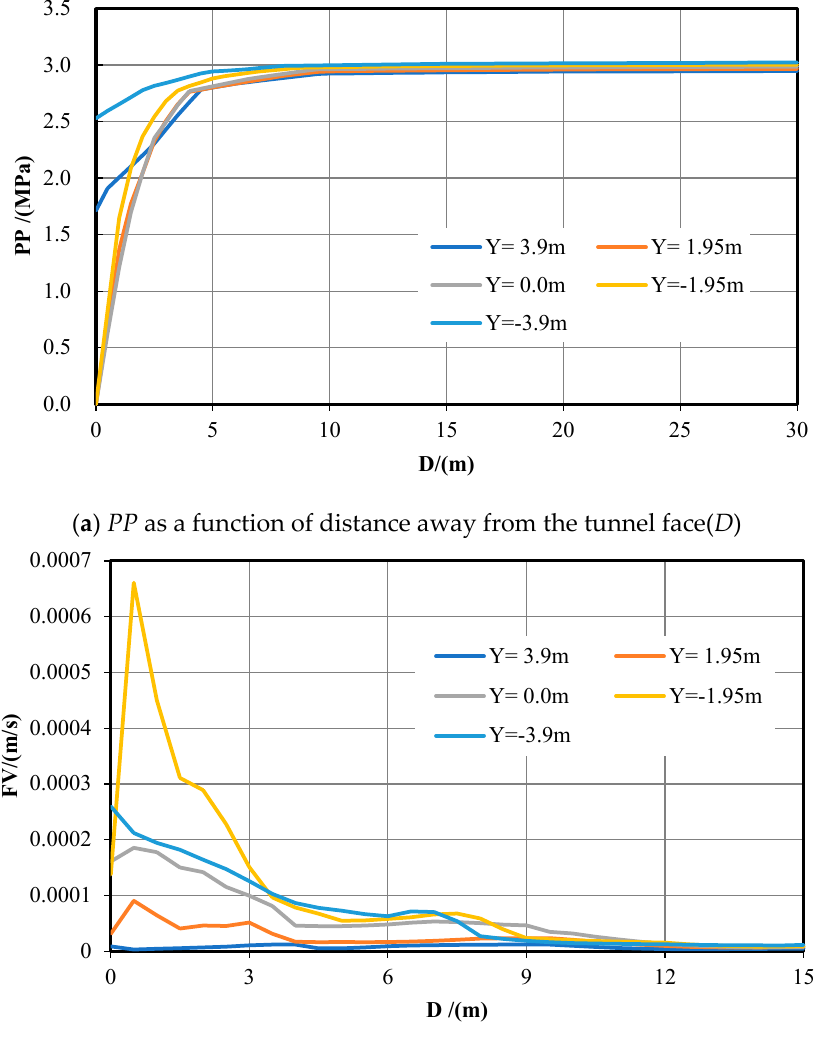
Figure 9. Pore pressure and flow velocity within 30 m ahead of the tunnel face as a function of distance away from the tunnel face (Y = − 20 m).